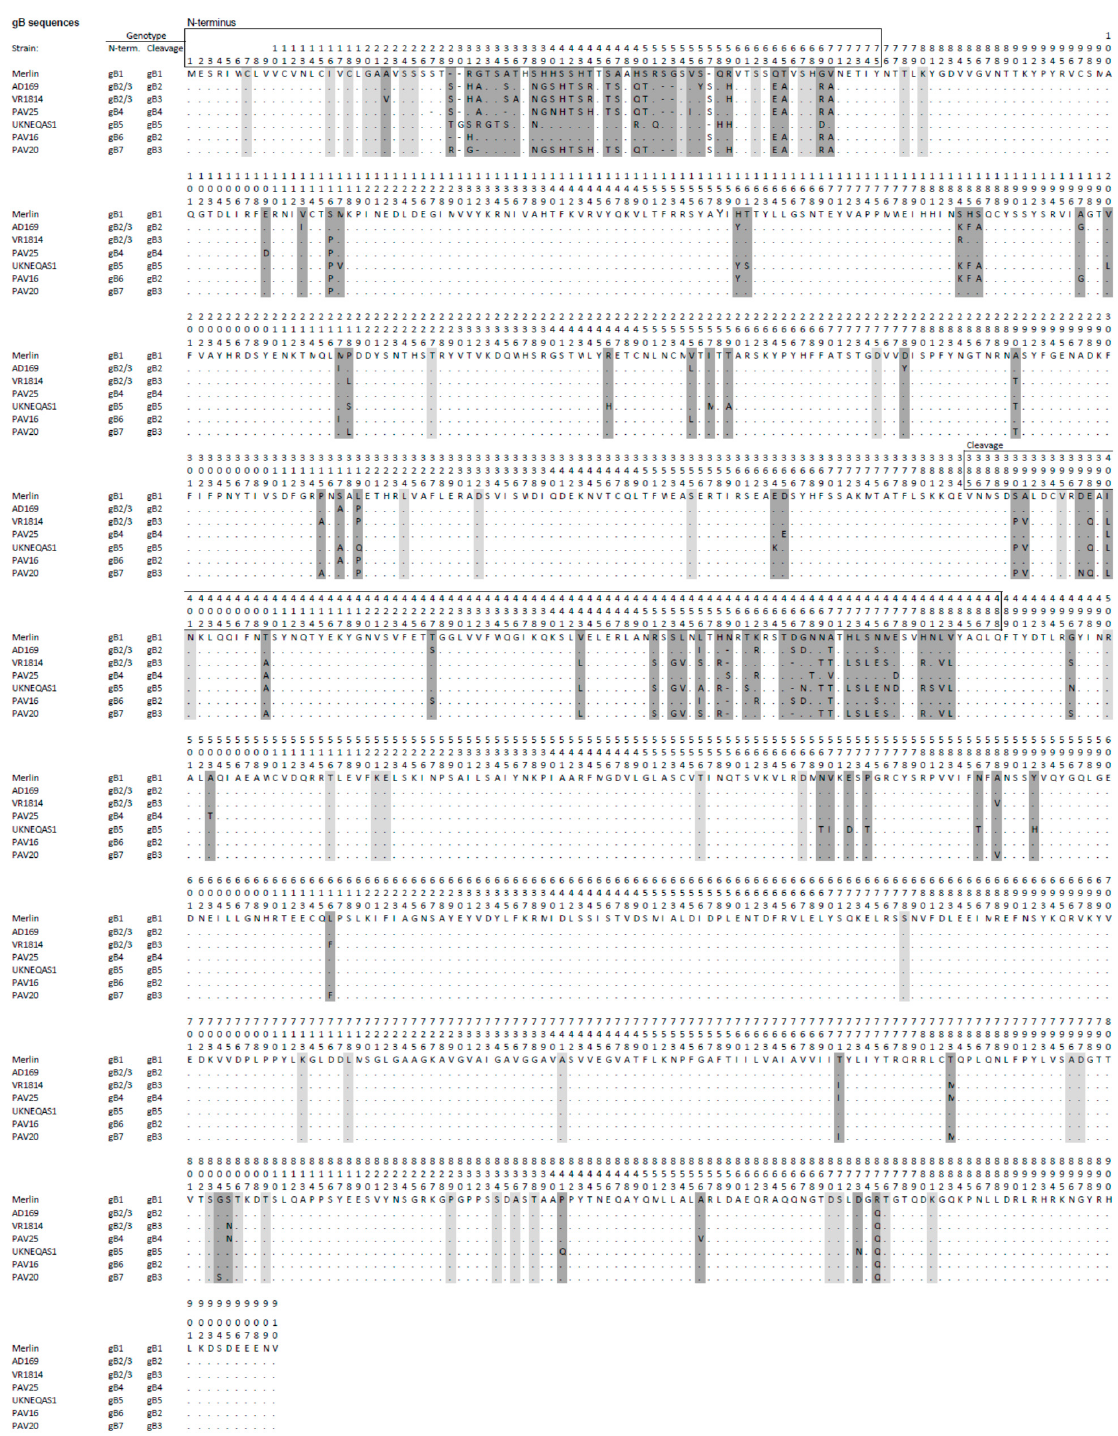
Figure 2. Predicted primary amino acid sequences representing the seven gB genotypes (gB1-7) in HCMV strains, with the strain Merlin sequence (gB1) shown as the reference. Amino acid residues that differ from those in the reference are reported, residues that are identical to those in the reference are indicated by dots, and gaps are shown by hyphens. Dark grey shading indicates major differences that characterize the genotype, and light grey shading denotes differences observed in individual strains. The numbers (1–910) above the sequences indicate residue numbering. Genotype classifications at the N terminus and cleavage regions are reported to the left of the